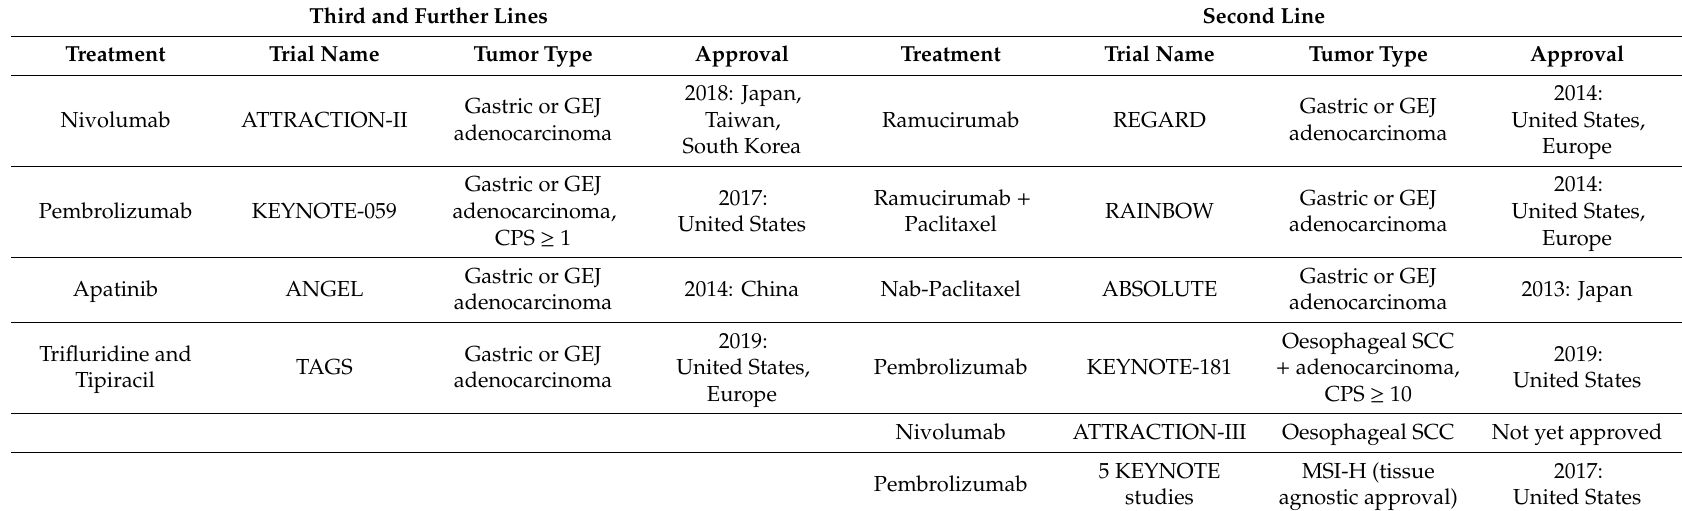
Table 2. Recent and expected approvals of second as well as third and further line therapy strategies in locally advanced and metastatic